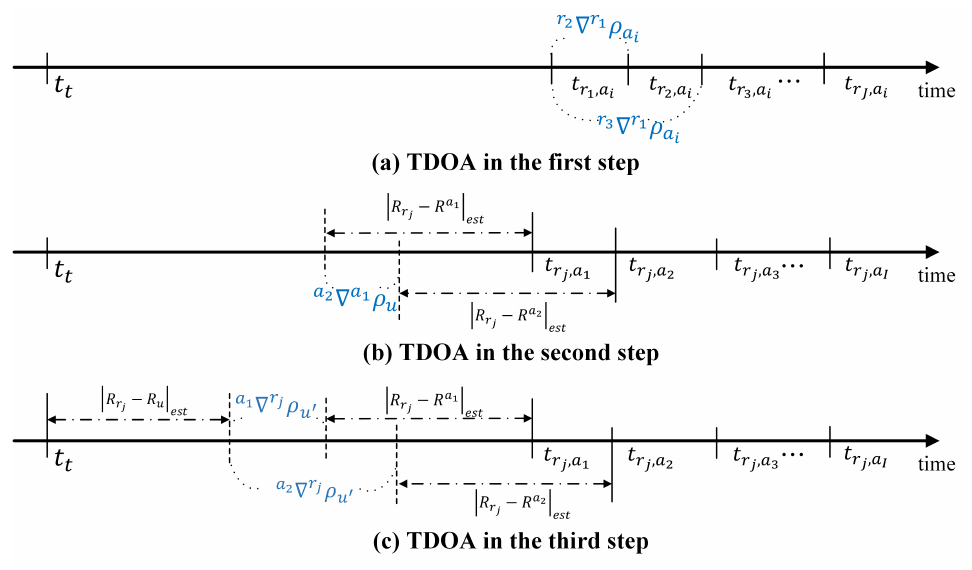
Figure 3. Time difference of arrival for each